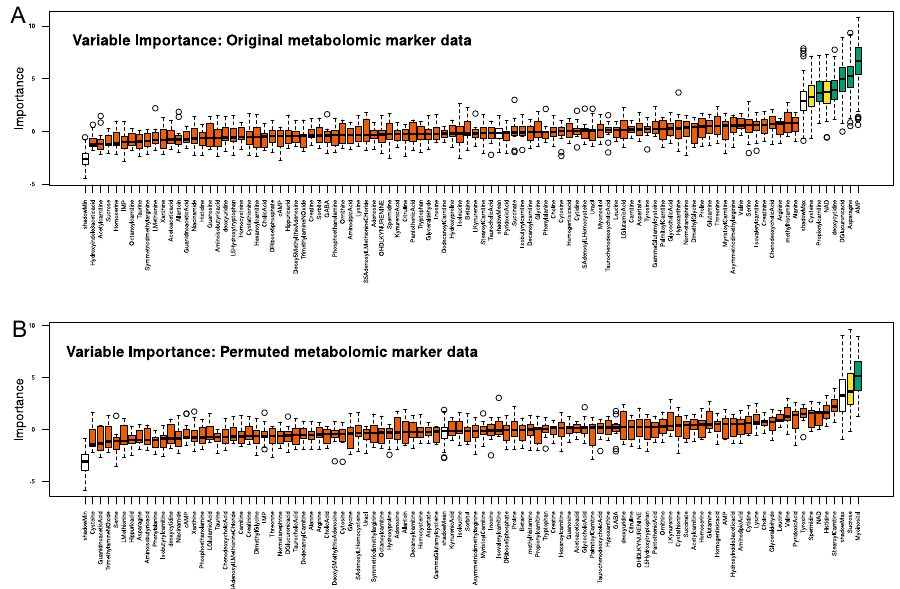
Figure 2. Identification and validation of metabolomic markers relevant for the assignment of patients to the correct pain phenotype subgroups. ( A ): Results of the variable selection procedure performed as random forest-based Boruta analysis, which assesses the measure of importance of a variable based on the decrease in classification accuracy due to random permutation of values in a 100-fold cross-validated approach. The importance measure is calculated separately for all trees in the forest that use the respective feature for classification. Then the mean value and the standard deviation of the loss of accuracy are calculated and the z-score is used in comparison to an external reference, the so-called “shadow” features (empty boxes), obtained by permuting the values of the original feature. Green and yellow boxes represent “confirmed” or tentatively significant features, respectively, i.e., features that contribute to the classification success and were selected for the validation analyses shown in the lower line of panels. The red boxes are confirmed as non-informative variables and excluded from further analysis. The boxes were constructed using the minimum, quartiles, median (solid line inside the box), and maximum of these values. The whiskers add 1.5 times the interquartile range (IQR) to the 75th percentile or subtract 1.5 times the IQR from the 25th percentile. The black circles indicate outliers from this interval. ( B ): Results of the Boruta feature selection analysis when instead of the original data, randomly permuted metabolic marker concentrations were used. The figure was created using the R software package (version 4.0.2 for Linux; https://CRAN.R-project.org/ [23]) and the R libraries “Boruta” (https://cran.r-project.org/package=Boruta [24]) and “ggplot2” (https: //cran.r-project.org/package=ggplot2